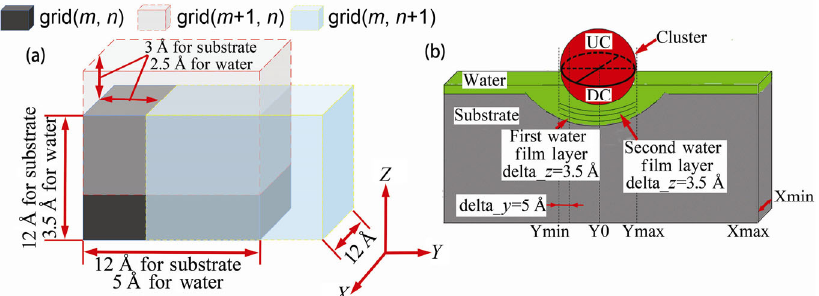
Fig. 2 (a) Calculation mode of local temperature and pressure of substrate or water film. (b) Calculation mode of density of water film layer and cluster